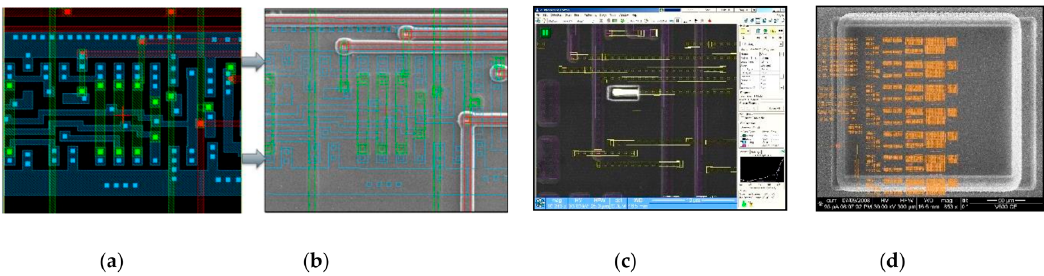
Figure 22. ( a ) CAD design ( b ) CAD overlay on FIB-SEM ( c ) FIB-trench created using the guidance of CAD ( d ) Backside image of FIB-trench. No circuit features visible—only CAD polygons of the active diffusion layer.